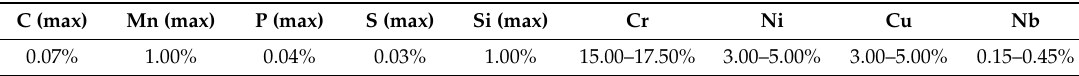
Table 4. Chemical composition of the 17–4 PH stainless steel [25].